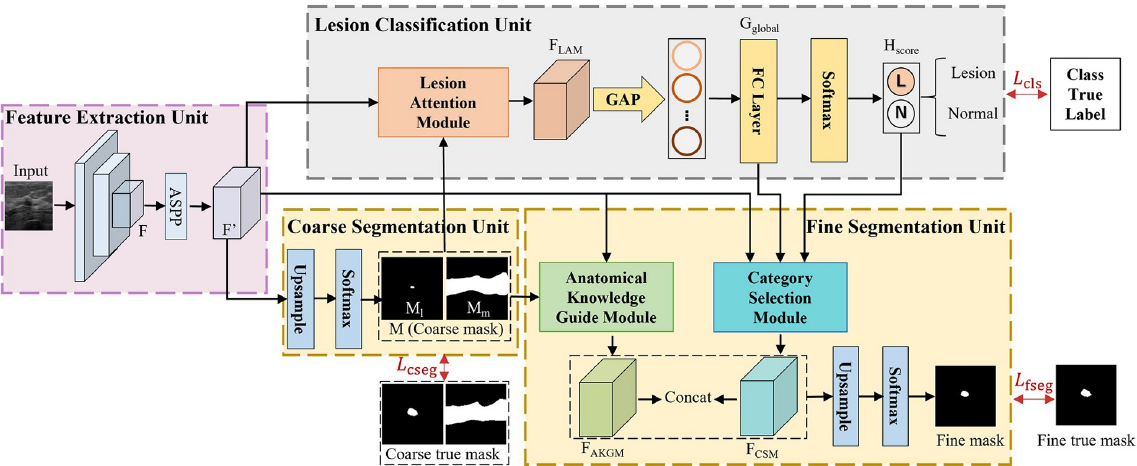
Fig 5. Architecture of the cross-task guided network (CTG-Net). The network comprises a shared features backbone and three units for BUS image classification and segmentation. ASPP, Atrous Spatial Pyramid Pooling; GAP, Global Average Pooling; FC, Fully Connected Layer; Concat, Features Channel